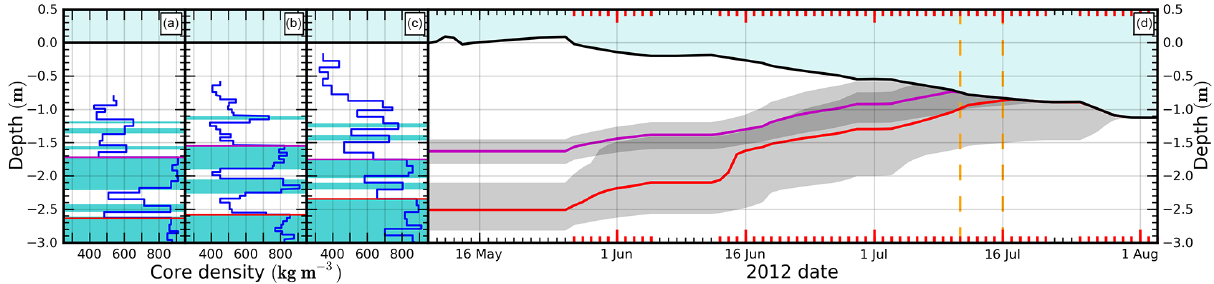
Figure 5. Panels (a–c) show the density profiles of three shallow firn cores drilled at AWS_U in April 2012. The water table is indicated in light blue and ice lenses observed in the core stratigraphy are indicated in cyan. Magenta and red lines indicate two potential sets of “blocking” ice lenses observed in the firn. Panel (d) shows a model simulation of the near-surface water table at AWS_U for each of the two blocking lens assumptions in (a–c) , with 95% confidence intervals in grey. Red ticks on the horizontal axes indicate days above freezing when surface melt would occur. As snow melts above the blocking lenses the water table rises simultaneously until it meets the lowering snow surface. Light blue is free air. The daily snow surface is observed by the adjacent AWS_U AWS. The two dashed orange vertical lines indicate 11 July, the date of the Watson River Bridge destruction and 16 July, when the Landsat image from Fig. 1 shows horizontal water transport in the vicinity of AWS_U. Table 2. Melt contributions (km 3 ) from different elevation intervals integrated through to the end of the melt season, 1 October each